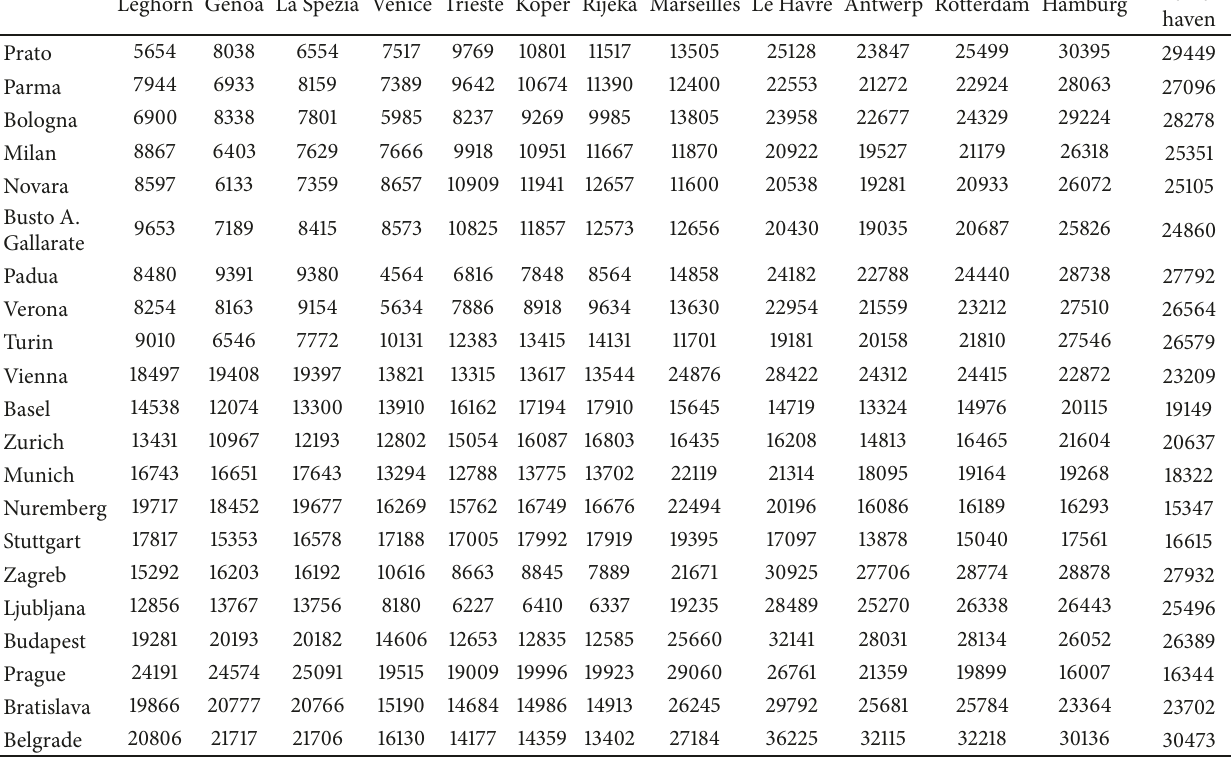
Table 5: Monetary costs (in €) per train, from each origin port (shown in the columns) to each destination city (shown in the rows) resulting from the optimisation by monetary